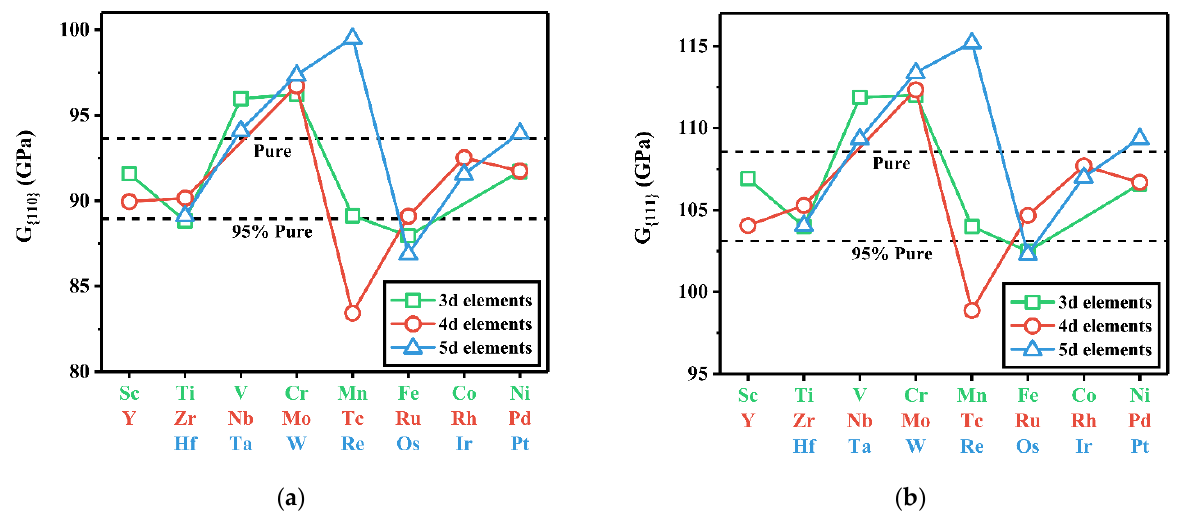
Figure 7. Shear modulus in ( a ) {110} plane and ( b ) {111} plane of the X-substituted γ′ -Co 3 Nb.